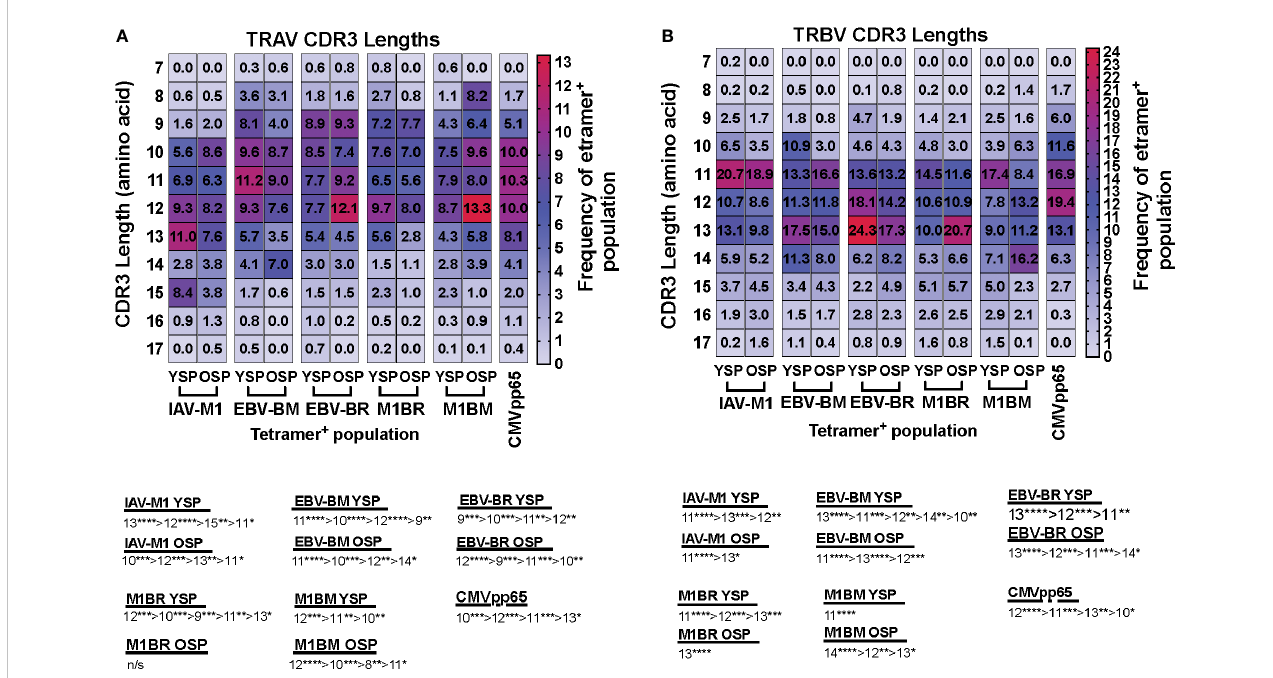
FIGURE 3 TRAV and TRBV CDR3 lengths of IAV-M1 and EBV epitope speci fi c responses differ between young and older donors. TRAV and TRBV CDR3 lengths (amino acids) were determined for IAV-M1, EBV-BM, and EBV-BR cognate and cross-reactive short-term cultured CD8 T cells that were tetramer-sorted and sequenced (Y n=4, O n=4-5). M1BM or M1BR are cross-reactive EBV-BM or EBV-BR single tetramer+ cells sorted from IAV-M1 stimulated short term cultures. CMVpp65 epitope speci fi c responses were used as a control, which included young and middle-aged donors (n=3). Heatmap analyses of preferential TRAV CDR3 length usage shows different preferential hierarchies between different epitope-speci fi c responses and for the same epitope between Y and O in TRAV (A) and TRBV (B) . Below heatmap is the hierarchy of the dominant CDR3 lengths used by the indicated response. Multi-variant 2-way ANOVA with adjusted p-value, *p < 0.05, **p < 0.01, ***p < 0.001, ****p <